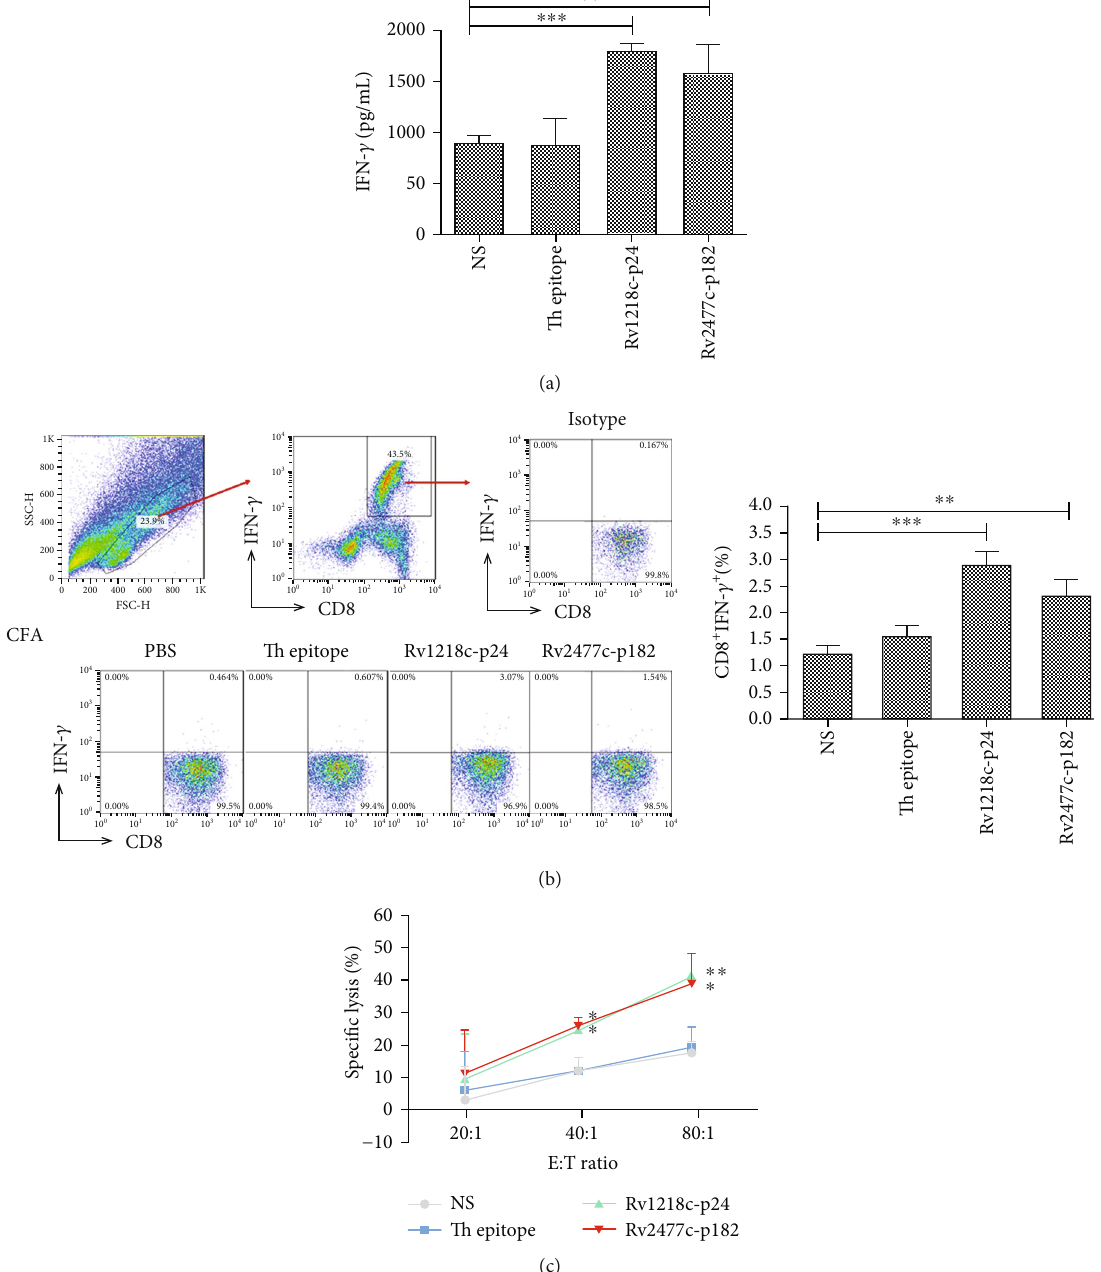
Figure 5: Activity of CTLs induced with peptide after preimmunization with CFA in HLA-A2.1/K b transgenic mice. Complete Freund ’ s adjuvant (CFA, 200 μ L) was injected subcutaneously into HLA-A2.1/K b transgenic mice ( n = 5 ) on day-14. The mice were then subcutaneously immunized at the base of the tail with each peptide (100 μ g/mice) and T helper epitope (140 μ g/mice) emulsi fi ed with incomplete Freund ’ s adjuvant (IFA) at 1:1 three times (on days 0, 5, and 10). On day 11, all mice were sacri fi ced and the serum was collected from each mouse to measure the IFN/- γ concentration (a). The splenic lymphocytes were isolated from each mouse and restimulated once with each peptide (10 μ g/mL) and mIL-2 (10 U/mL) in vitro for another 6 days. On day 7, the IFN- γ release in each group was measured with an intracellular cytokine staining (ICS) assay (b) and the lysis activity were measured with an LDH assay (c). Peptide-loaded T2A2 cells were used as the target cells. Normal saline (NS) group and Th epitope only group were the negative controls. Statistical signi fi cance was determined with Student ’ s t -test ( n = 5 ). ∗ P < 0 : 05 , ∗∗ P < 0 : 01 , and ∗∗∗ P < 0 : 001 represent the signi fi cance of di ff erences relative to the NS